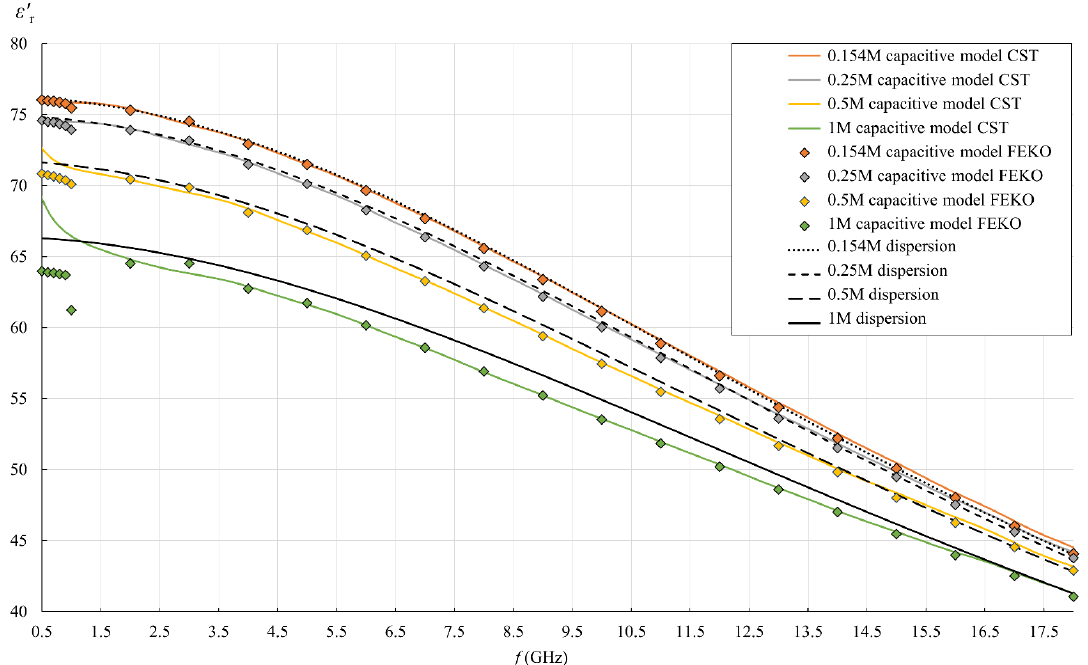
Figure 13. ε (cid:48) r for all saline solutions: simulation results obtained by postprocessing the reflection coefficient using the simple capacitive-load model (“capacitive model”), where the reflection coefficient was obtained by simulations either in CST (colored lines) or in FEKO (discrete points); Cole–Cole dispersion model (“dispersion”), which was the set ε (cid:48) r value for MUT in simulations (black lines).